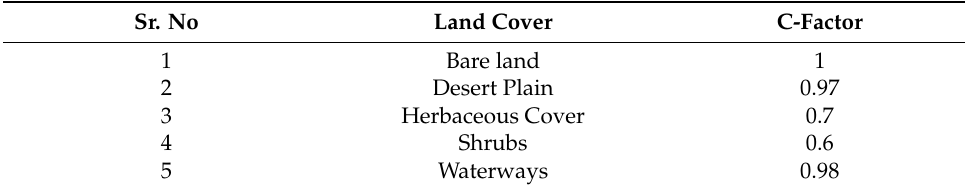
Table 4. C-factor